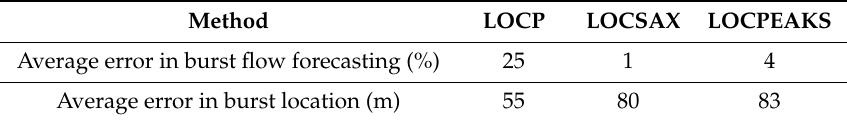
Table 1. Jardim Laudissi network results for distance and leaked